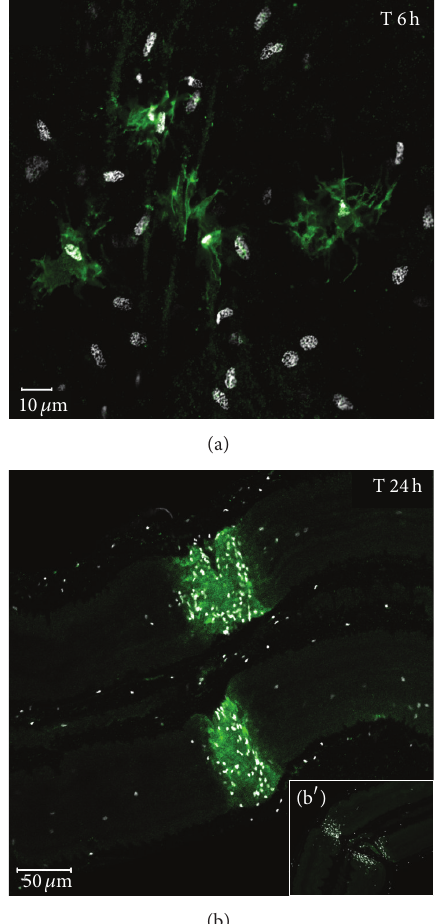
Figure 6: Immunostaining of leech central nervous system (CNS) using rabbit polyclonal anti-human C1qBP antibodies (green). Microglial cell nuclei (white) were stained with Hoechst fluorescent dye to observe cell migration. (a) High magnification image of the injury site after 6 hours. Since all microglia nuclei are shown by Hoechst counterstaining (white), images demonstrate that the anti- C1qBP immunostaining selectively enhances some microglial cells. (b) 24 hours following injury, the number of microglial cells is much higher at the lesion site, and stronger positive immunostaining is observed. (b 󸀠 ) No immunostaining was observed using secondary antibodies alone as negative controls. (Reprinted, with permission, from